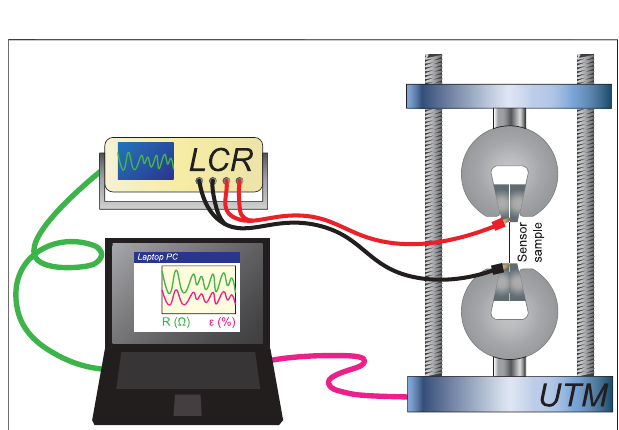
FIGURE 2 | A schematic of the experimental set-up, consisting of a universal testing machine (UTM) driven to strain a sensor sample, inductance-capacitance-resistance (LCR) meter for sensor measurement, and laptop PC to control the UTM and log the resulting strain and sensor signal